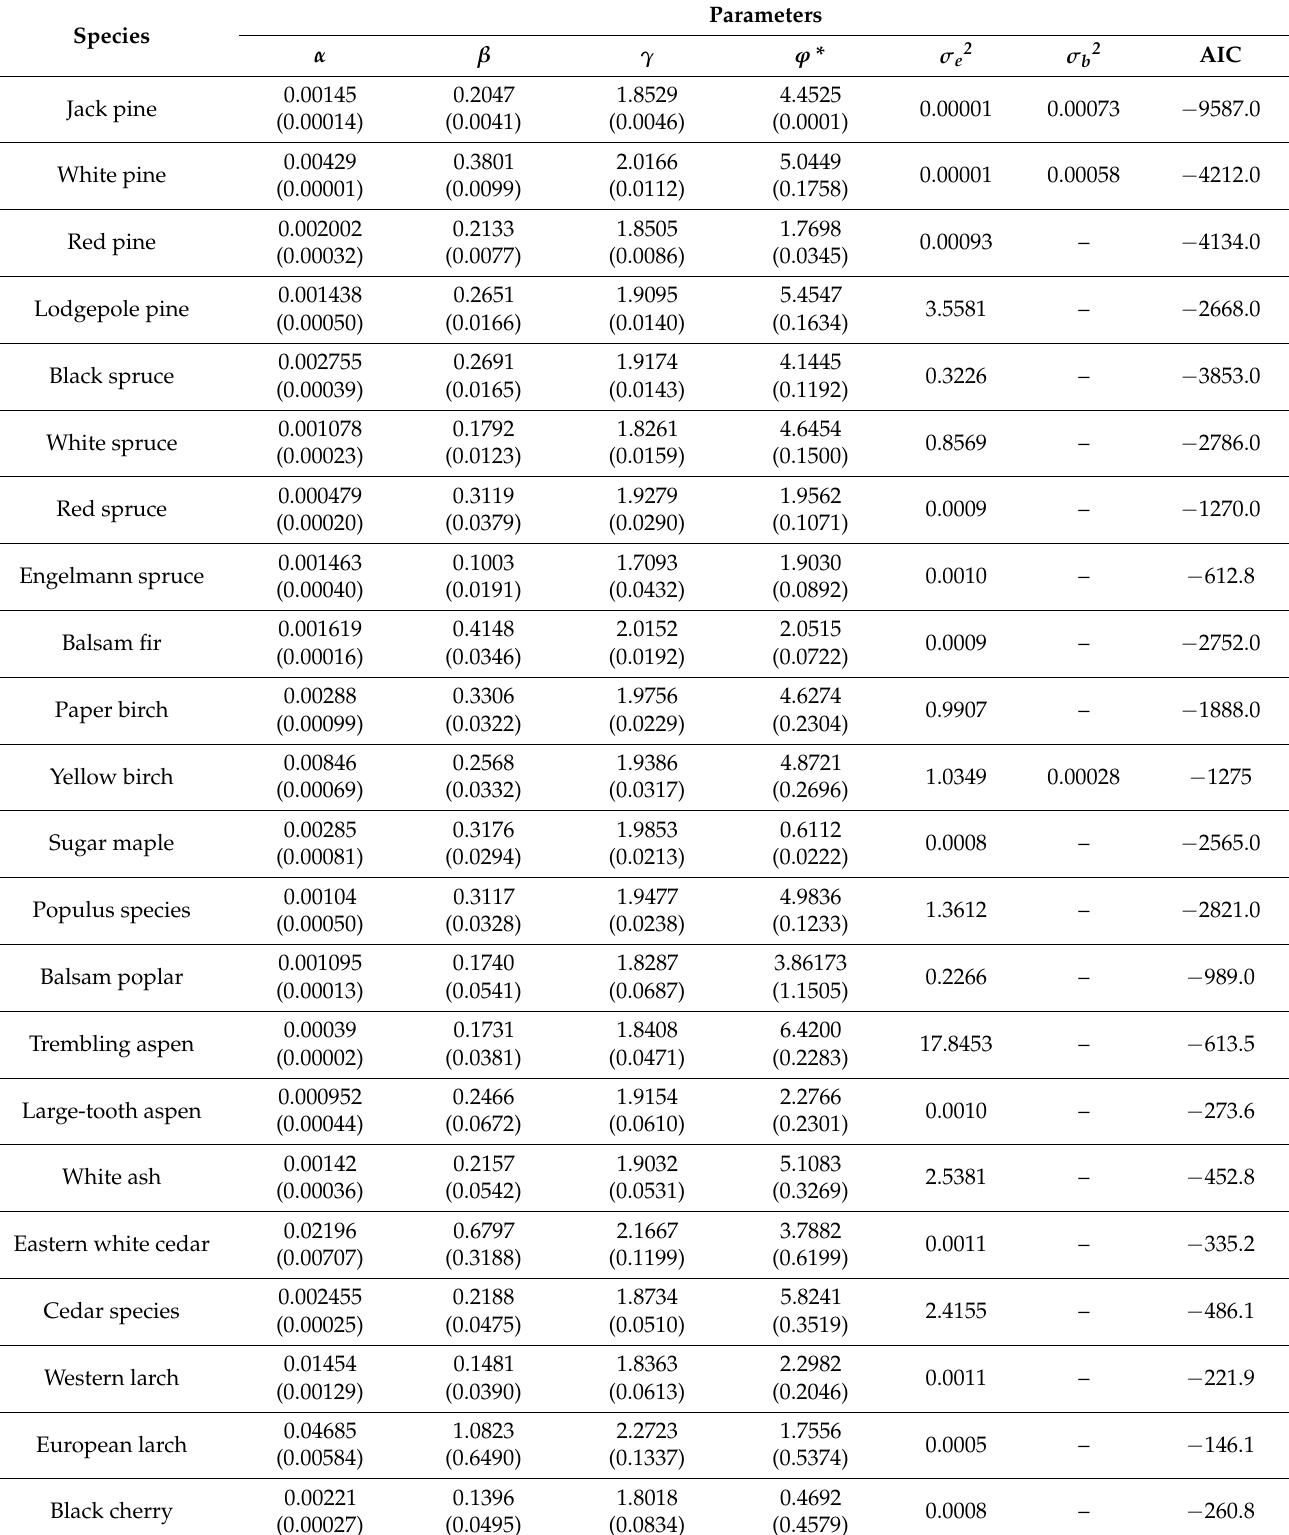
Table 3. Parameter estimates (standard error) and fit statistics (MSE ( σ e 2 ), variance of b ( σ b 2 ), and AIC (Akaike’s